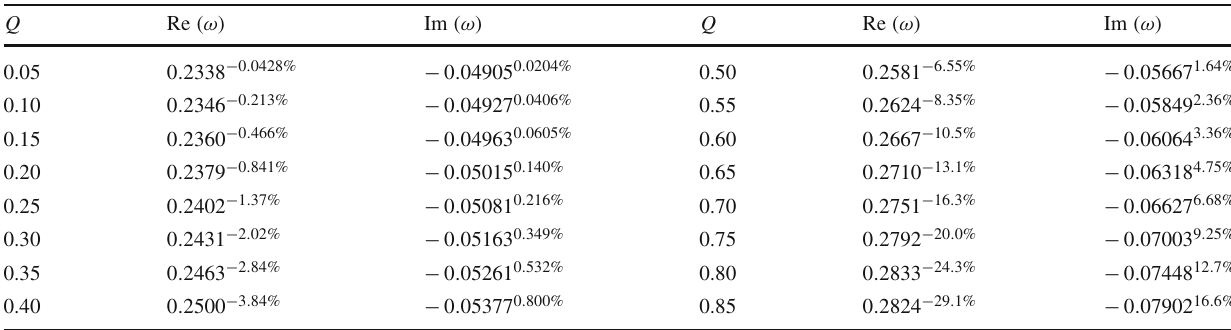
Table 4 Fundamental quasinormal modes for non-minimally coupled scalar field evolving in RNdS black holes with different values of Q . The spacetime parameters read M = L / 6 = (cid:2)/ 2 = η/ 50 = 1 and